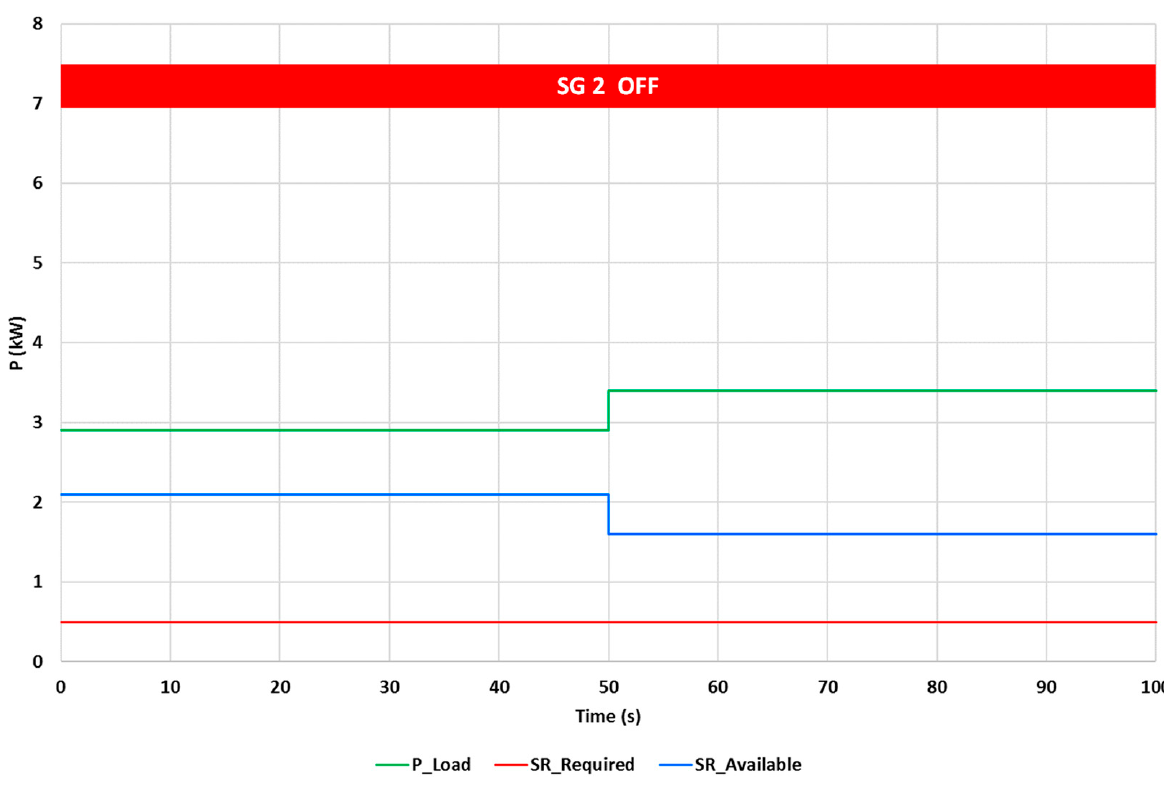
Figure 19. Power demand, SR values and activation status of SG2 in the case with non-priority loads (proposed method) .